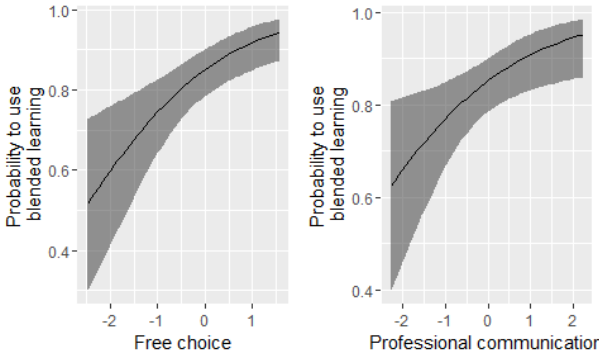
Figure. 5. Graphs of dependence of the probability of using the blended learning model on factors